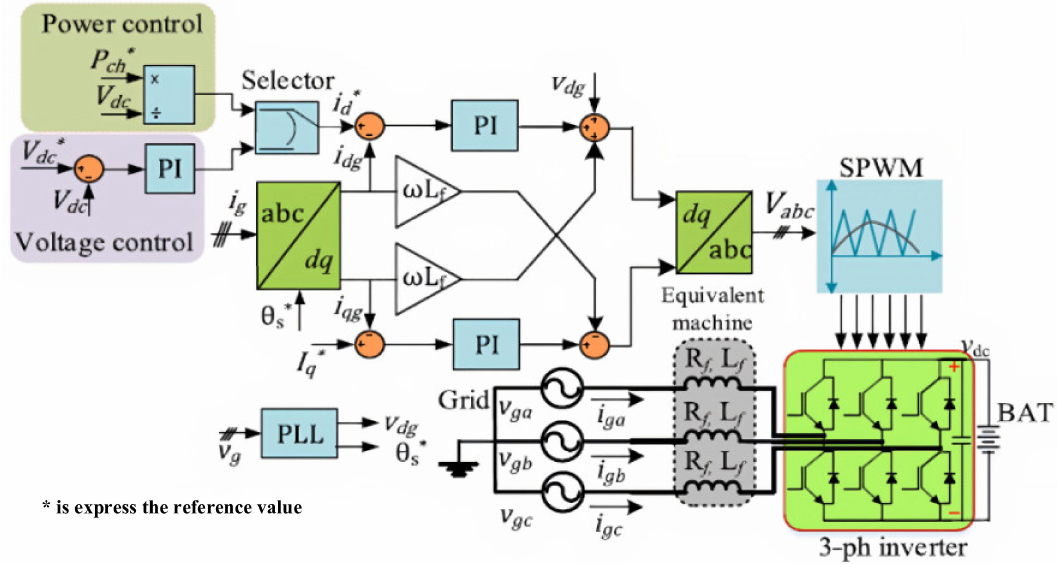
Figure 16. Three phase charging based on equivalent three-phase grid connected inverter